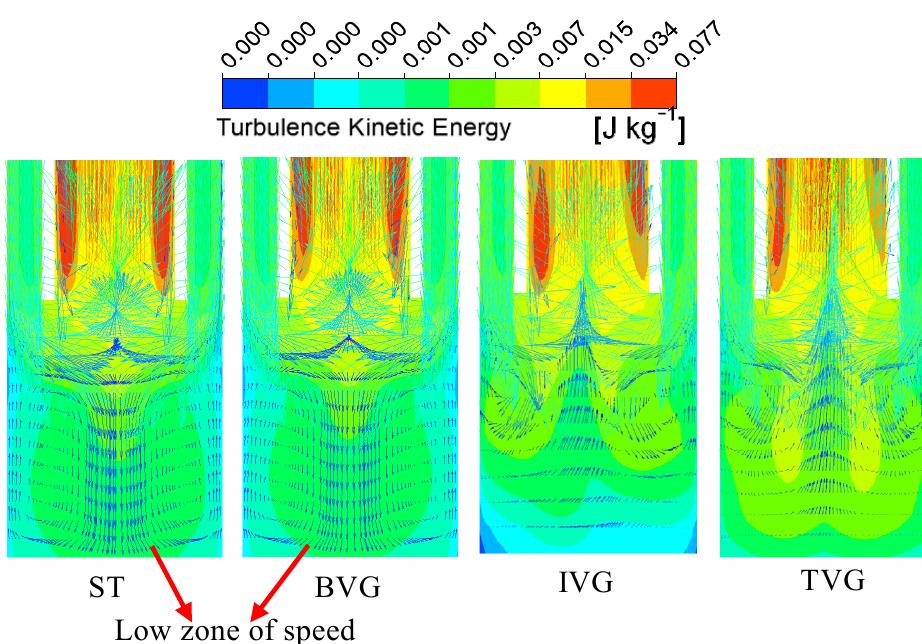
Figure 7. Distributions of turbulent energy and velocity vector at the bottom hole of the different longitudinal sections of the four heat exchangers.